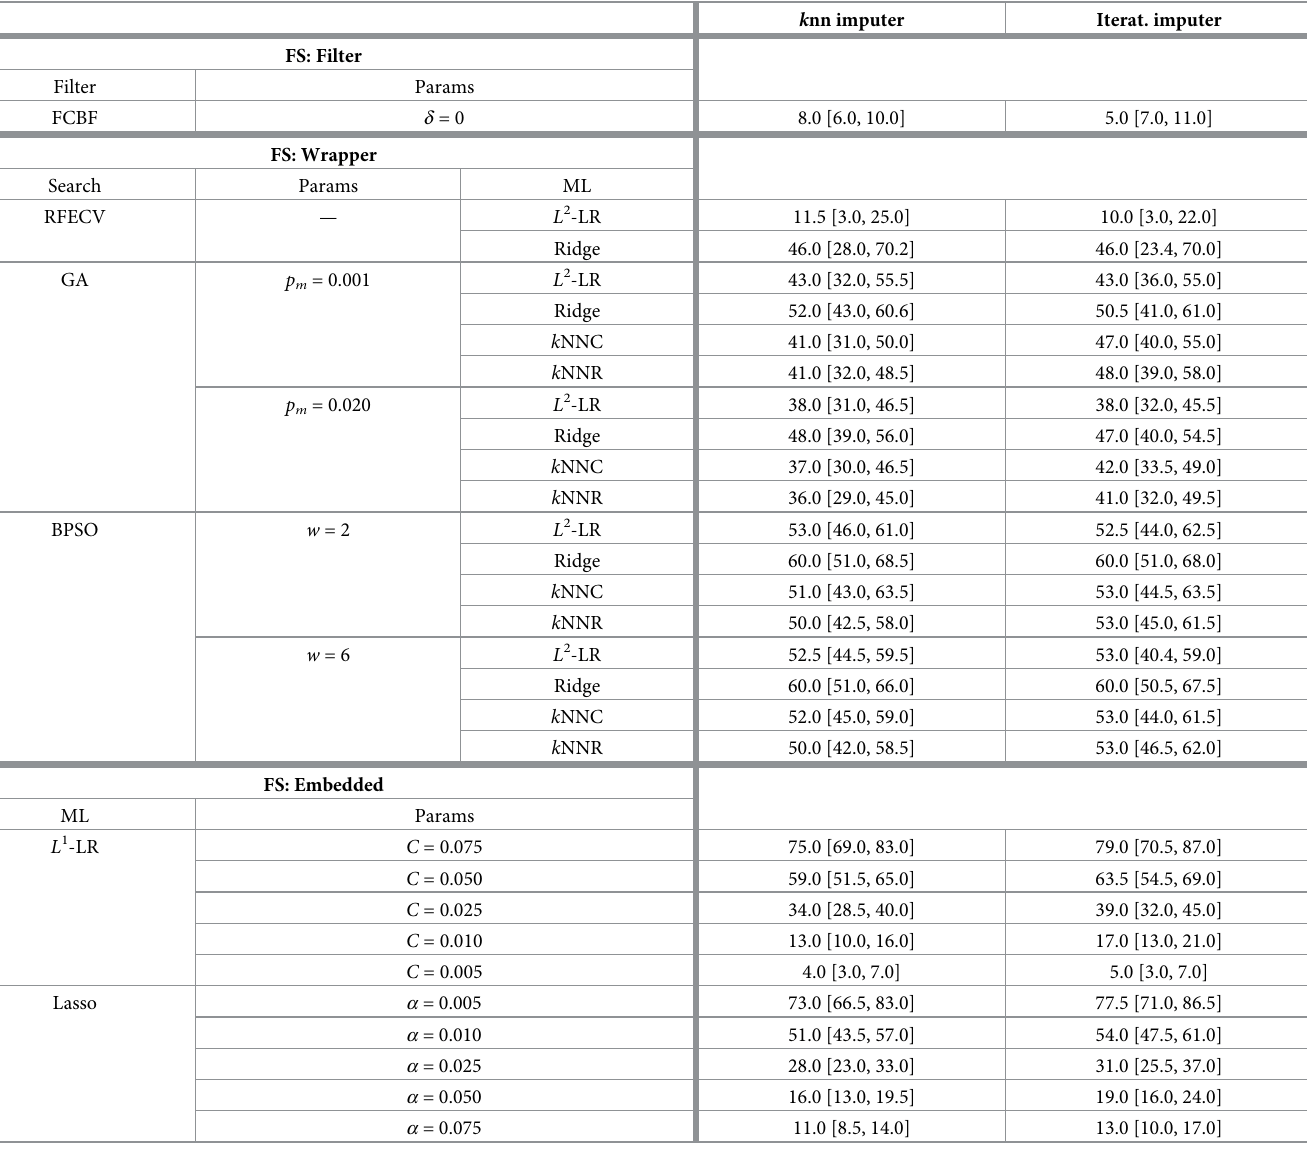
Table 5. Number of selected features for algorithms with non-fixed n FS . Median and 95% percentile range.